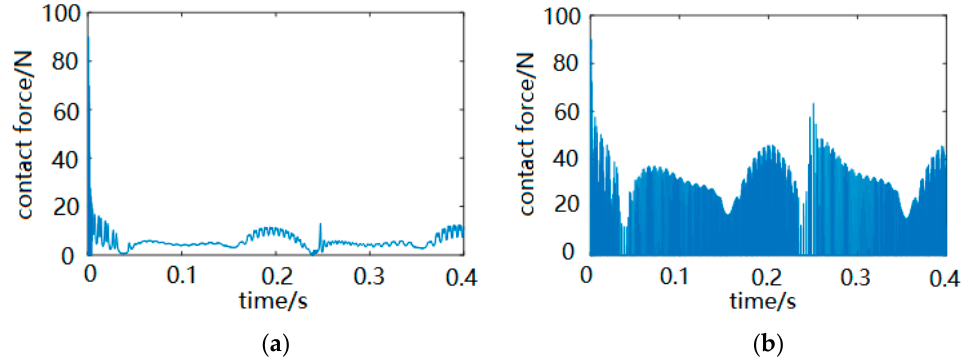
Figure 13. Change in contact force with time: ( a ) constant coefficient of restitution model, ( b ) new coefficient of restitution model.